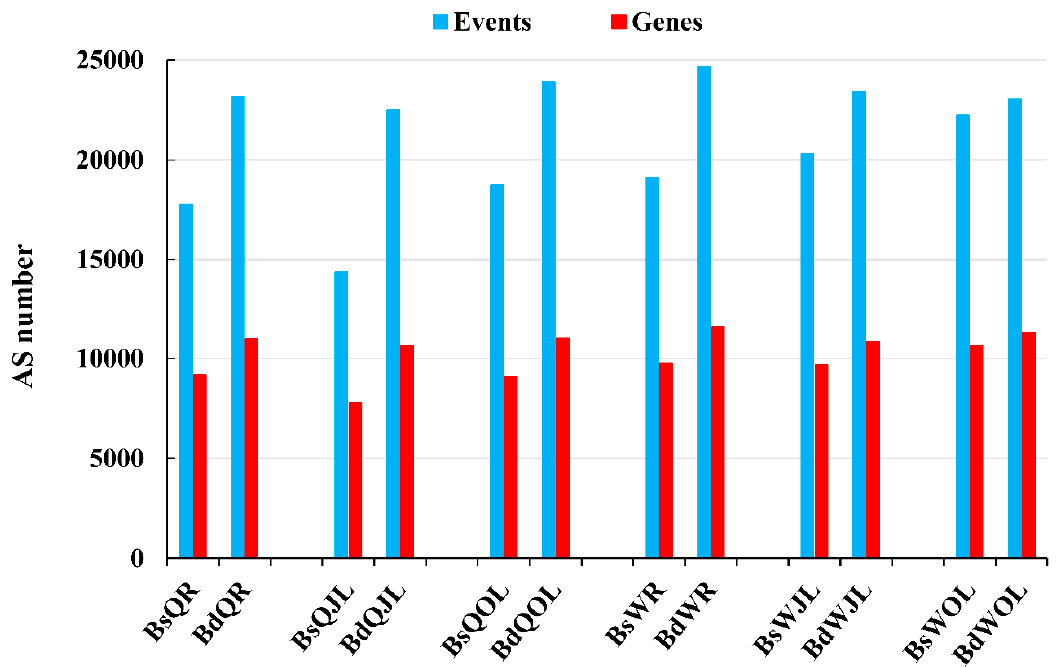
Figure 4. The numbers of the alternative splicing (AS) events and genes in B. napus cultivars Qingyou10 (QY10) and Wesatr10 (W10) under boron (B) sufficient and deficient conditions. Q, QY10, Qingyou10; W, W10, Westar10; Bs, B sufficient condition; Bd, B deficient condition; R, root; JL, juvenile leaves; OL, old leaves.